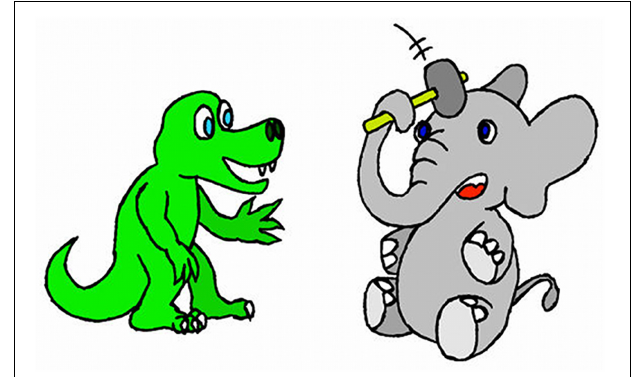
FIGURE 2 | Example of picture showing a self-oriented